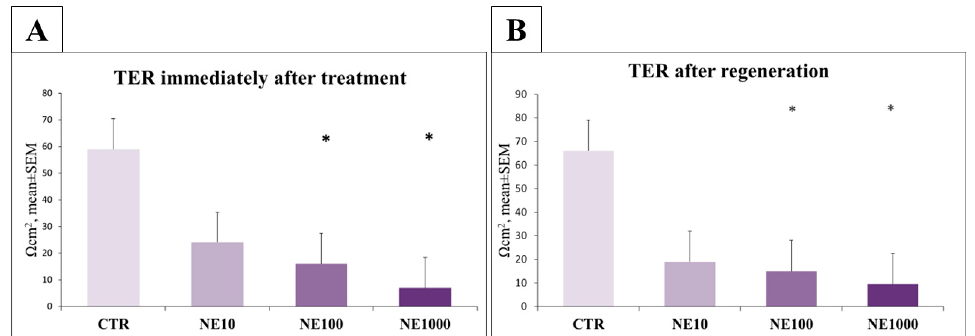
Figure 12. Transepithelial electrical resistance (TER) of uroepithelial cell cultures measured imme- diately after norepinephrine treatment ( A ) and after 24 h regeneration time ( B ). CTR = non-treated control cells, NE10 = 10 µ M norepinephrine treated cells, NE100 = 100 µ M norepinephrine treated cells, NE1000 = 1000 µ M norepinephrine treated cells. n = 3/group, results are expressed as mean ± SEM, * p < 0.05 .